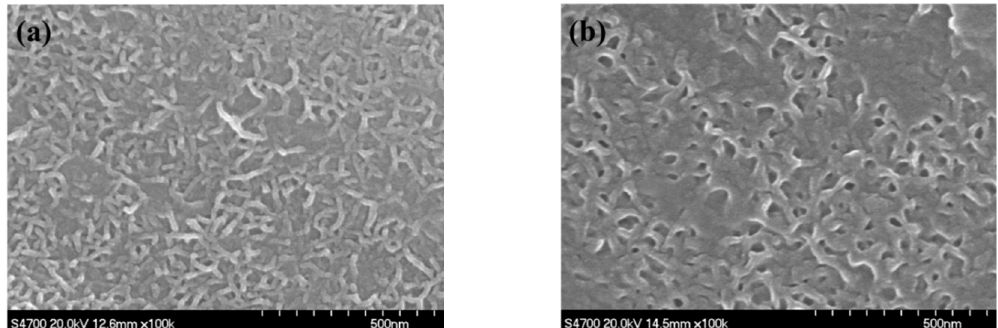
Figure 9. SEM images of the substrate surface underneath ( a ) MRP after 339 days of immersion in the simulated acid rain solution and ( b ) SAP-MRP after 397 days of immersion in the simulated acid rain